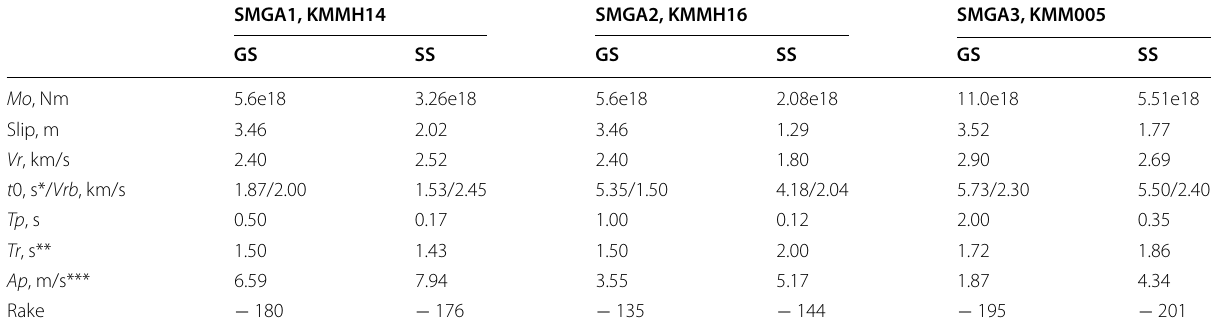
Table 3 SMGA parameters at Steps 1 to 6 of the inversion procedure (by grid search, GS, and simplex search, SS). For location of SMGAs and hypocenters, see Fig. 6